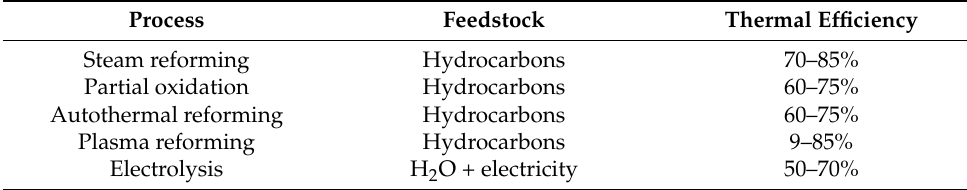
Table 2. Comparative data on the efficiency of hydrogen production methods [29]. Process